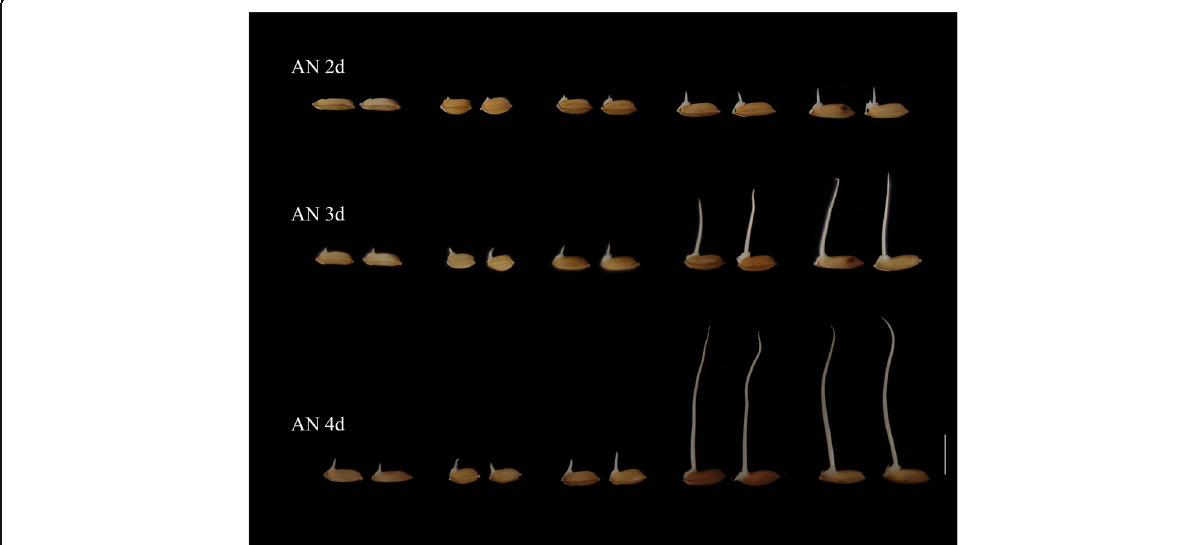
Fig. 1 Phenotypic variation of coleoptile in different rice germplasm at different submerging time points. AN is for anaerobic environment. Scale = 1 cm